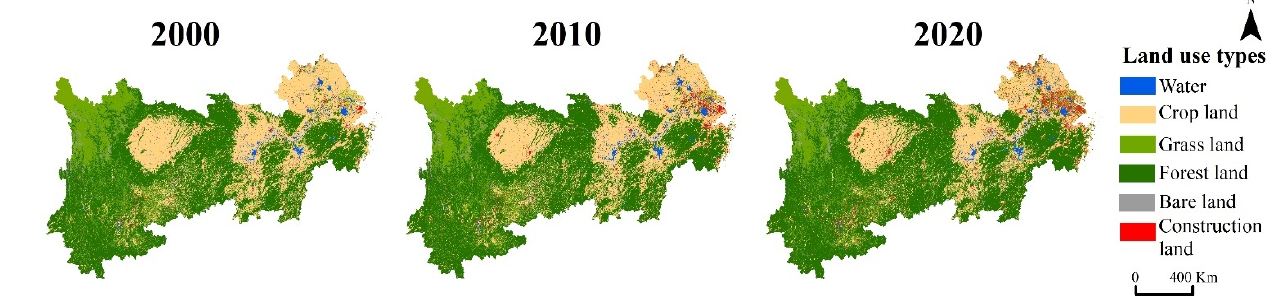
Table 1. The land use patterns change from 2000 to 2020 in the YREB (km 2 ).